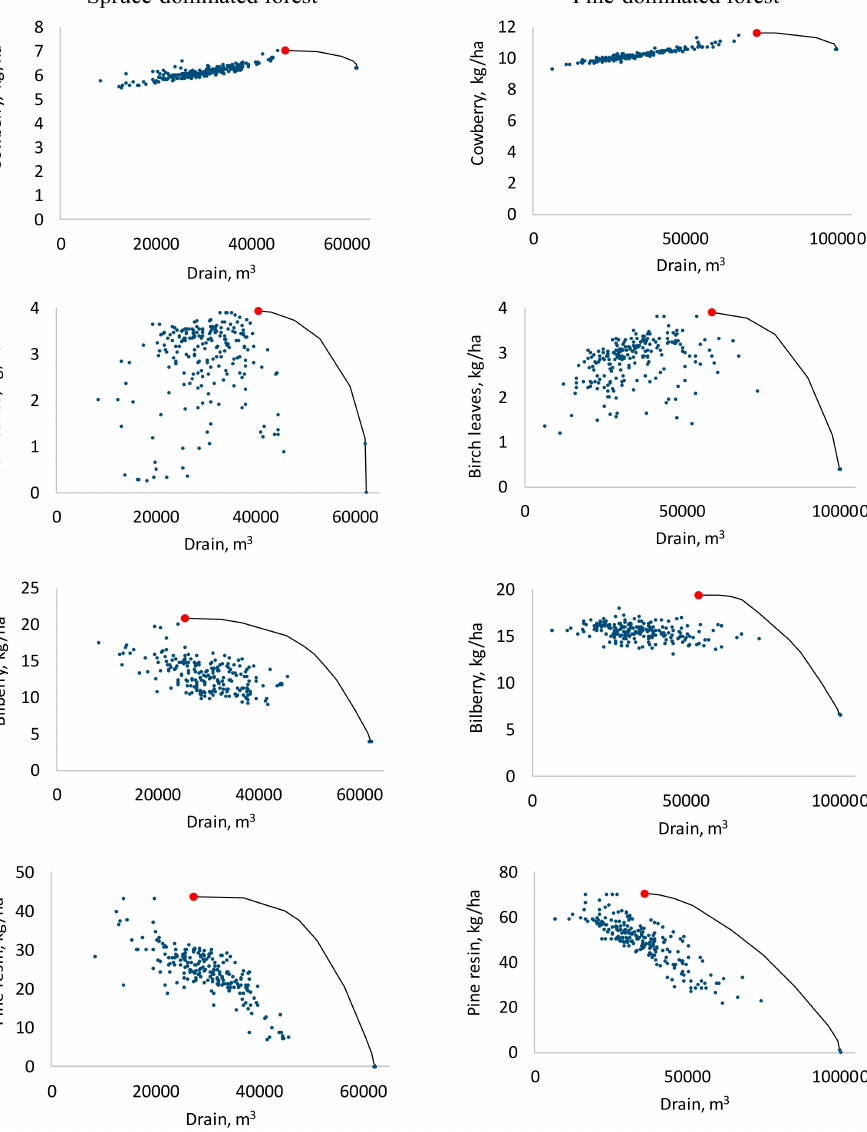
Figure 1. The production possibility frontiers between drain and selected NWFPs (lines) for spruce and pine-dominated forest holdings and the solutions from the 200 alternative pareto-optimal forest plans (dots). The red point is the single-objective maximum of the